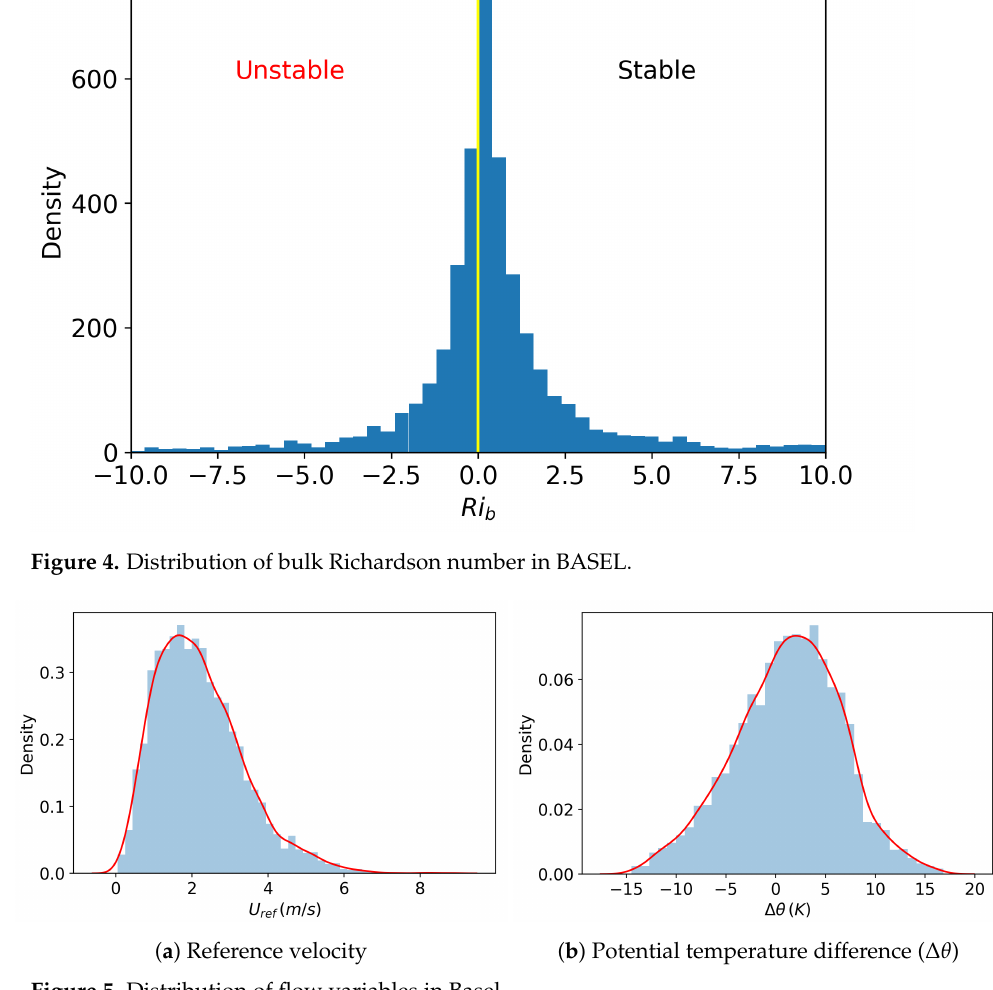
Figure 5. Distribution of flow variables in Basel.